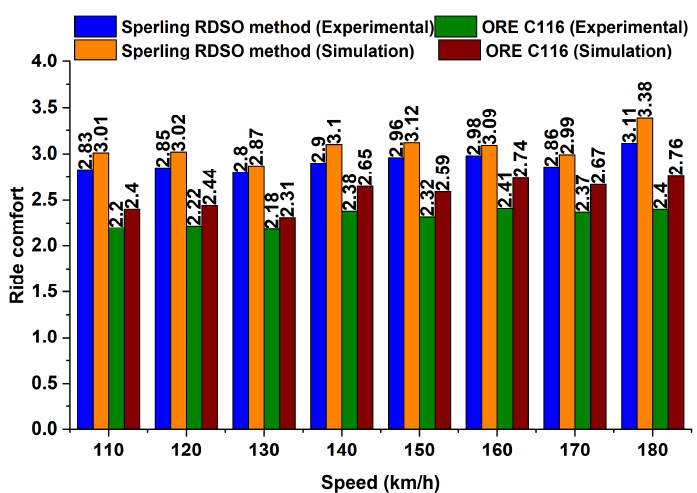
Figure 5. Comparison of numerical and experimental analysis for loaded condition.